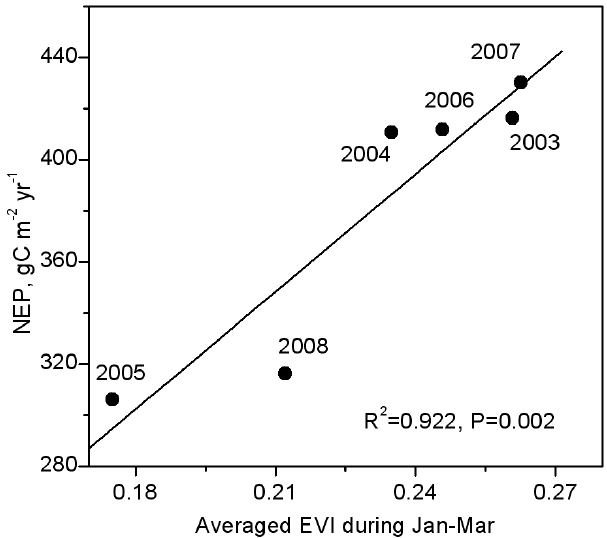
Fig. 7. Relation between the EVI of January through March and annual net ecosystem production.